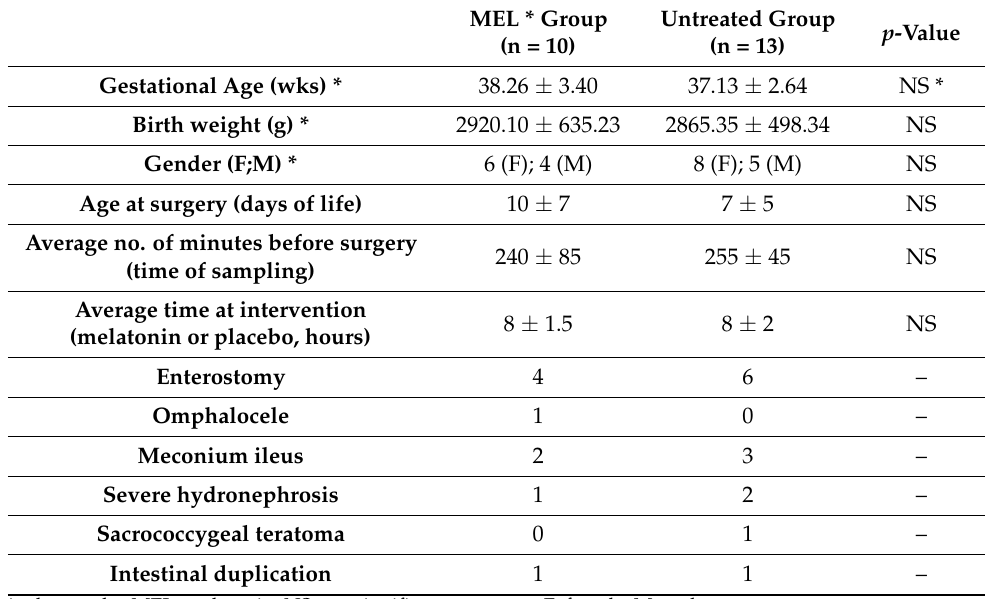
Table 1. Clinical characteristics of the enrolled patients.